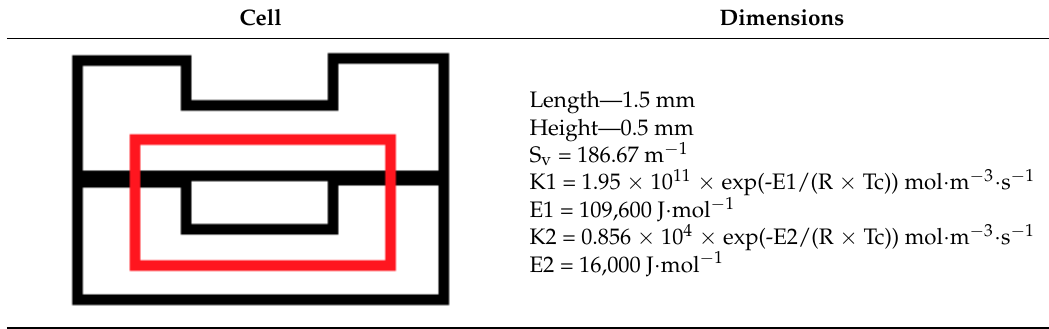
(21) y gi —concentrations in gas phase, mole fraction; y si —concentrations in solid phase, mole fraction; u —velocity of gas, m/s; ɛ —catalyst fraction; S v —the specific surface ‐ to ‐ volume ratio in the channel, m − 1 , β —mass transfer coefficient, m/s; c p —gas heat capacity, J m − 3 K − 1 ; c s —catalyst heat capacity, J m − 3 K − 1 ; T g —gas phase temperature, К ; T s —solid phase temperature, К ; α —mass transfer coefficient, m/s; T furnace —temperature in the furnace, К ; λ —thermal conductivity of the catalyst;